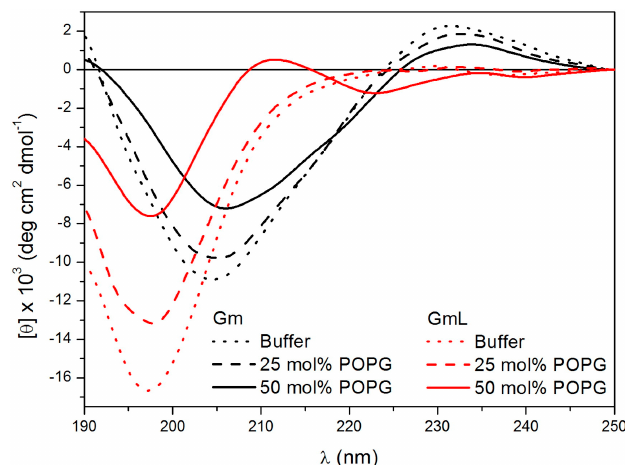
Figure 2. Circular dichroism spectra of Gm and GmL in an aqueous solution and in the presence of POPC with 25 mol % or 50 mol % POPG. Images reprinted from Domingues et al. [26]. Copyright (2015), with permission from Elsevier.